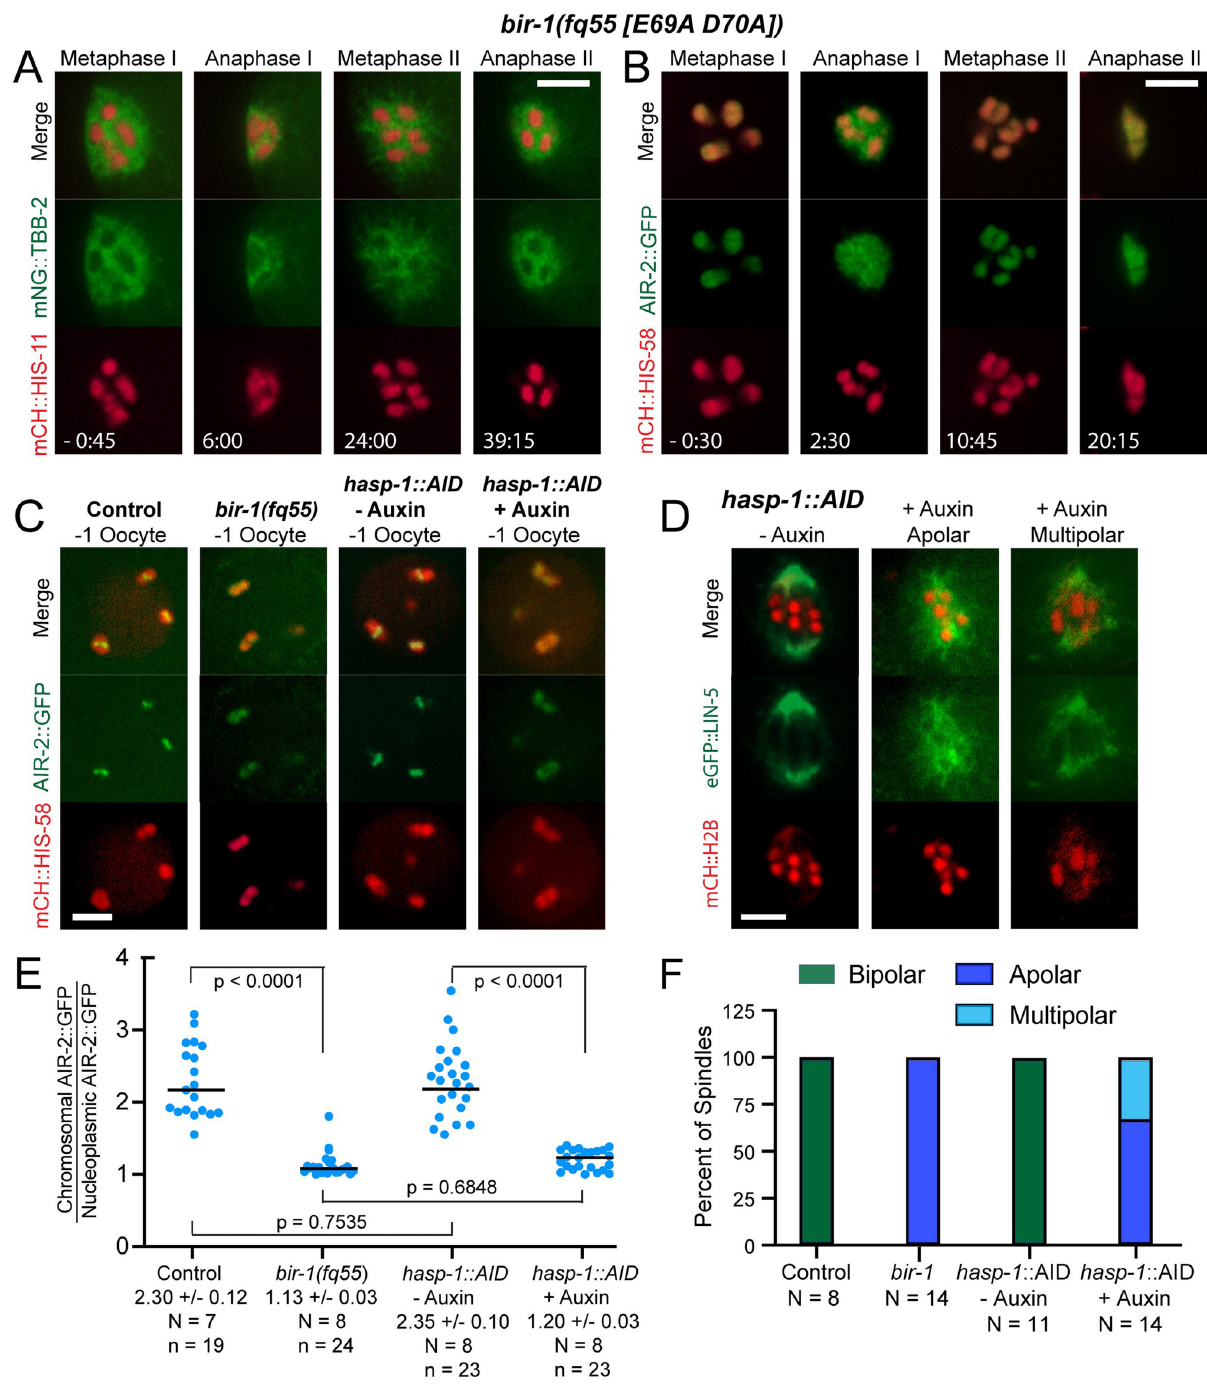
Fig 6. AIR-2 is recruited by Survivin and Haspin for bipolar spindle formation. (A) Time-lapse images of 14/14 bir-1(fq55) embryos expressing mNG::TBB-2 and mCH::HIS-11 show disorganized MI spindles and no MI anaphase chromosome separation. An example of a bir-1(+)/bir-1(+) control with the same transgenes is shown in Fig 1A. (B) Similar results were obtained in 4/4 bir-1(fq55) embryos expressing AIR-2::GFP, which is diffuse on both MI and MII metaphase chromosomes and present in a broader pattern consistent with microtubules during anaphase. An example of a bir-1(+)/bir-1(+) control with the same transgenes is shown in Fig 5A. (C) Single slices from z-stack images of -1 oocytes in C . elegans expressing AIR- 2::GFP and mCH::HIS-58. 11/11–1 oocytes in bir-1(fq55) embryos had 6 mCH::HIS-58 labelled bodies. (D) Single-plane images of hasp-1 :: AID embryos expressing eGFP::LIN-5 and mCH::H2B. Left: Bipolar spindle without auxin (- auxin). Center: An apolar spindle with auxin (+ auxin). Right: A multipolar spindle with auxin (+ auxin). 10/10 MI spindles in Auxin-treated hasp-1 ::: AID embryos had 6 mCH::HIS-58 labelled bodies. (E) AIR-2::GFP pixel intensities on individual chromosomes were determined relative to nucleoplasmic background. N, number of oocytes. n, number of